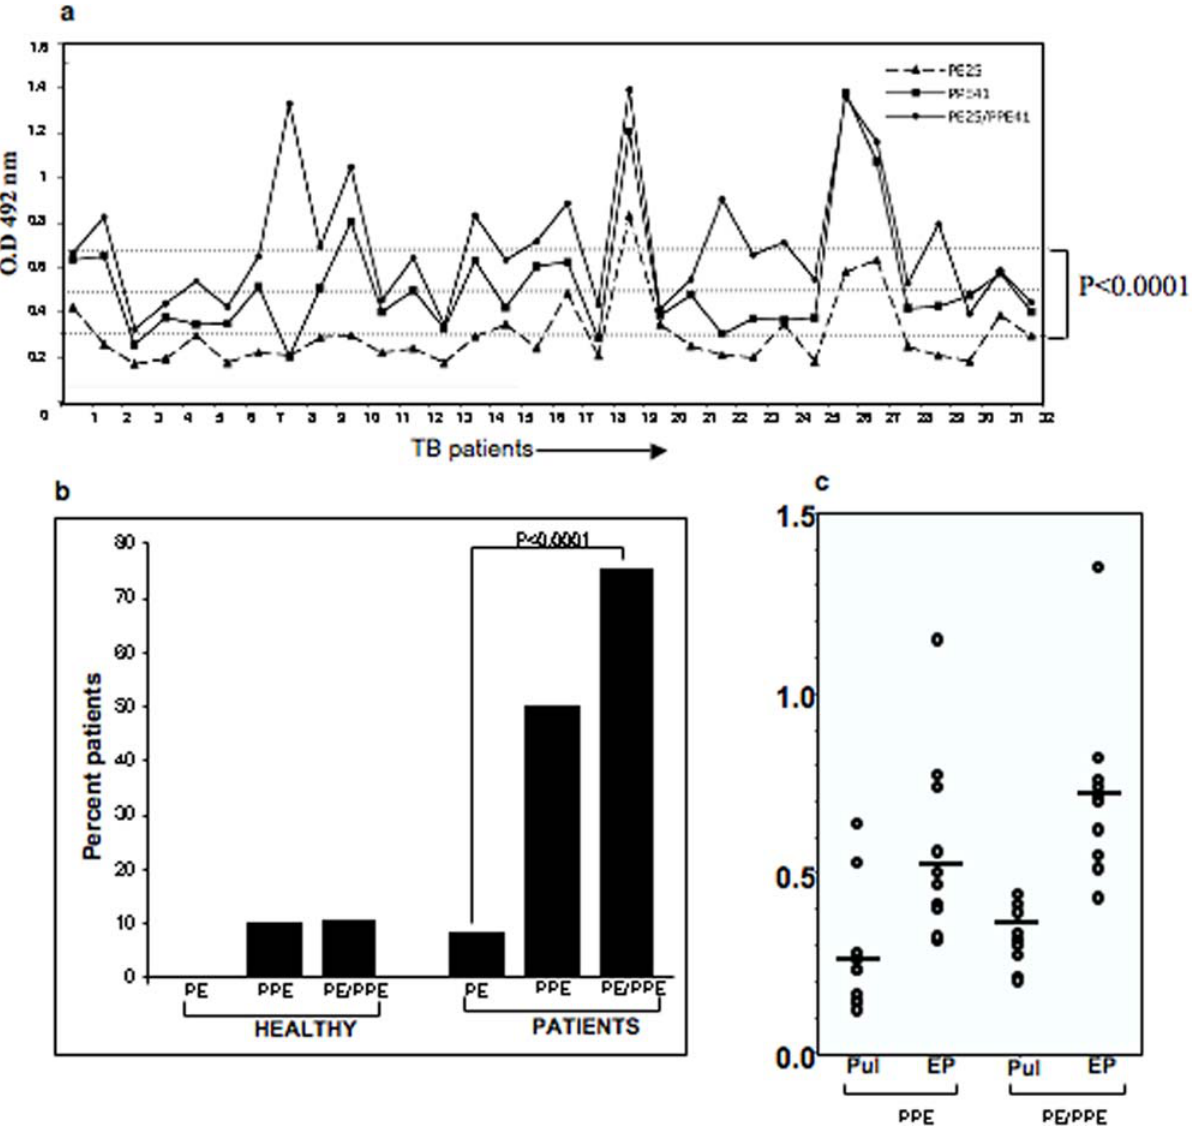
Figure 1. The PE25/PPE41 protein complex induces a much stronger antibody response in sera derived from TB patients. a) Sera from 32 TB patients were screened with the recombinant PE25 (dotted line with filled triangle), PPE41 (line with filled square) and PE25/PPE41 complex (line with filled circle) to score for the antibody response using ELISA. The P value (P , 0.0001) is between the groups screened with the PE25 and PE25/PPE41 protein complex. The three horizontal dotted lines represent the average absorbance (O.D) of antibody response against the three proteins respectively. b) ELISA was carried out with sera from 32 TB patients and 10 healthy individuals to calculate the percentage individual reactivity to the recombinant proteins. To calculate the percentage patients showing significant antibody response against each protein, cut-off value of O. D greater than 0.55 was used. c) Sera from patients belonging to pulmonary (Pul) and extra-pulmonary (EP) categories were screened with recombinant proteins PPE41 and PE25/PPE41 protein complex using ELISA to score for the antibody response. The horizontal lines represent the average O.D of the patients of each category against each protein.